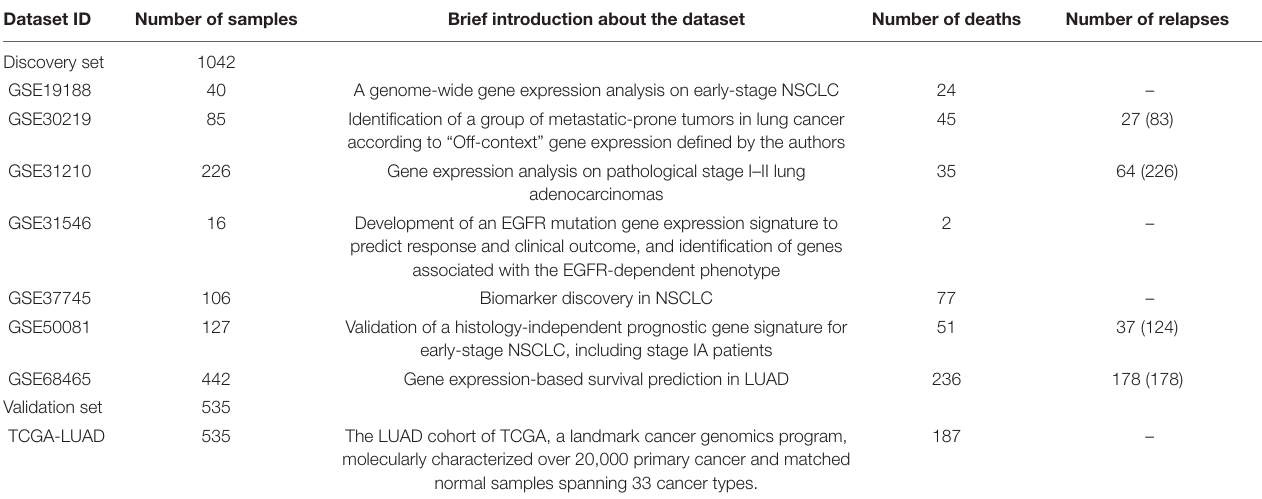
TABLE 1 | Basic information of datasets included in this